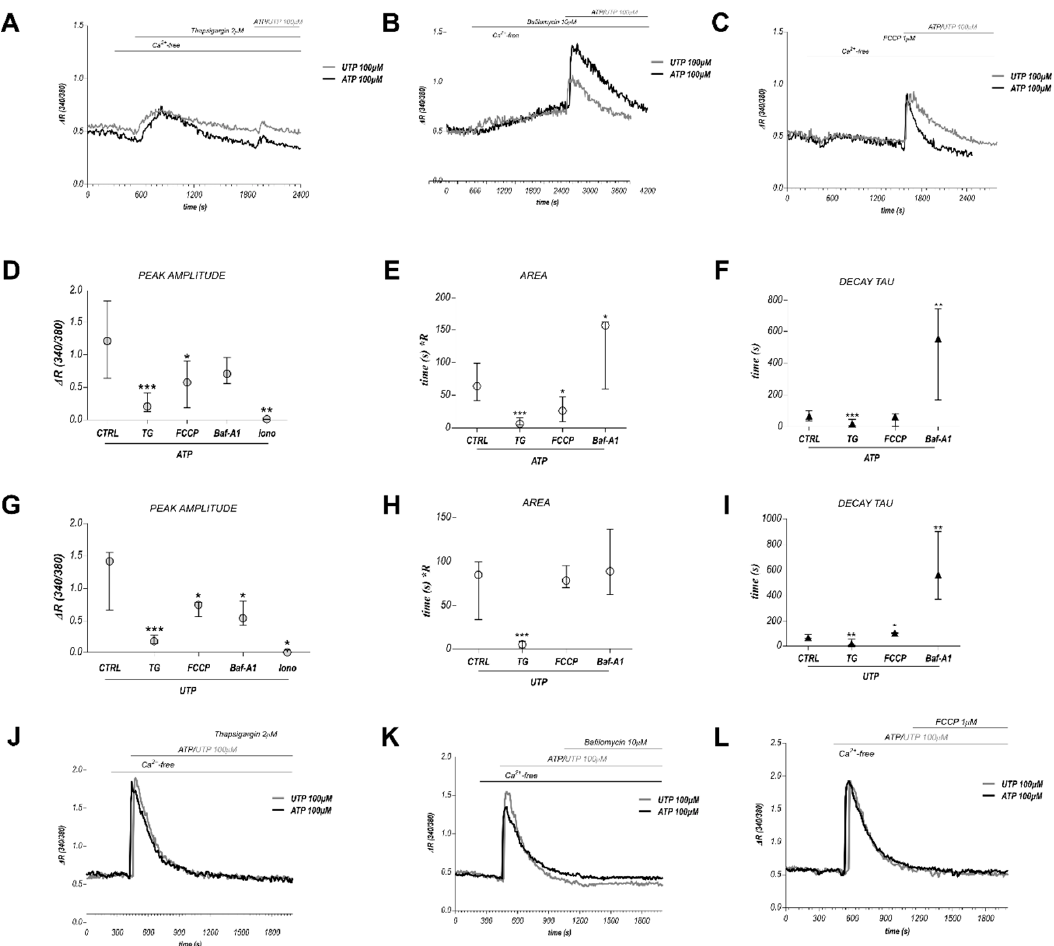
Figure 4. Interplay among different intracellular organelles in BTEC. ( A – C ) Effect of 2 µM TG, 10 µM Baf-A1 and 1 µM FCCP on the responses to 100 µM eATP or UTP. Representative traces. ( D – I ) Quantification of the previous experiments. Data are expressed as median over the total range of values. * p -value < 0.05; ** p -value < 0.005; *** p -value < 0.0005 vs. CTRL. ( J – L ) E ff ect of TG, Baf-A1 and